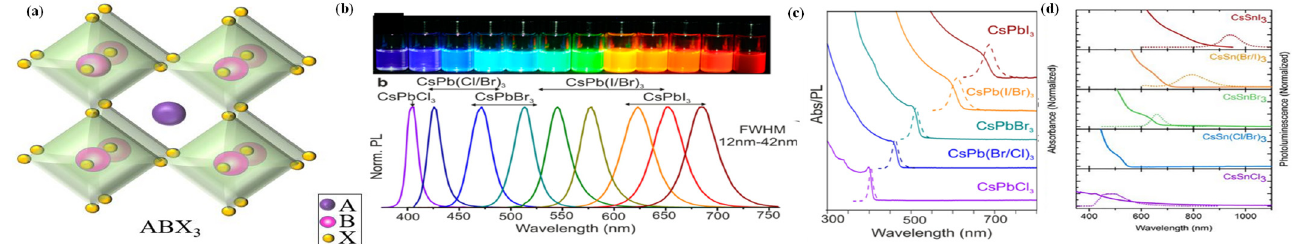
Figure 1. ( a ) Schematic illustration of the crystal structure of halide perovskite. ( b ) Colloidal halide perovskite CsPbX 3 NCs (X = Cl, Br, and I) exhibit size- and composition-tunable bandgap energies covering the entire visible spectral region with narrow and bright emission. ( c ) Typical optical absorption and PL spectra of CsPbX 3 NCs. ( d ) Typical optical absorption and PL spectra of CsSnX 3 NCs. (b,c) Reproduced with permission [70]. Copyright: 2015, American Chemical Society. (d) Reproduced with permission [71]. Copyright: 2016, American Chemical Society.